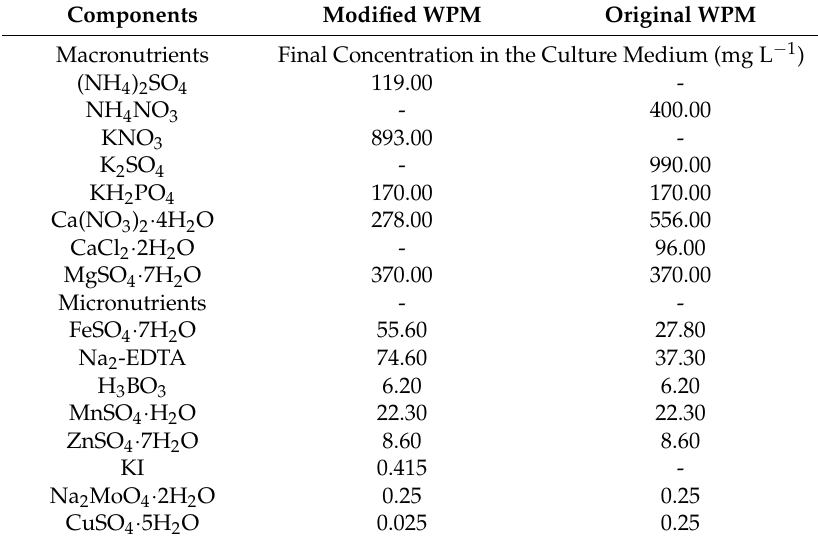
Table 1. Modified Woody Plant Medium (modified WPM) [15] and original WPM [18] culture medium